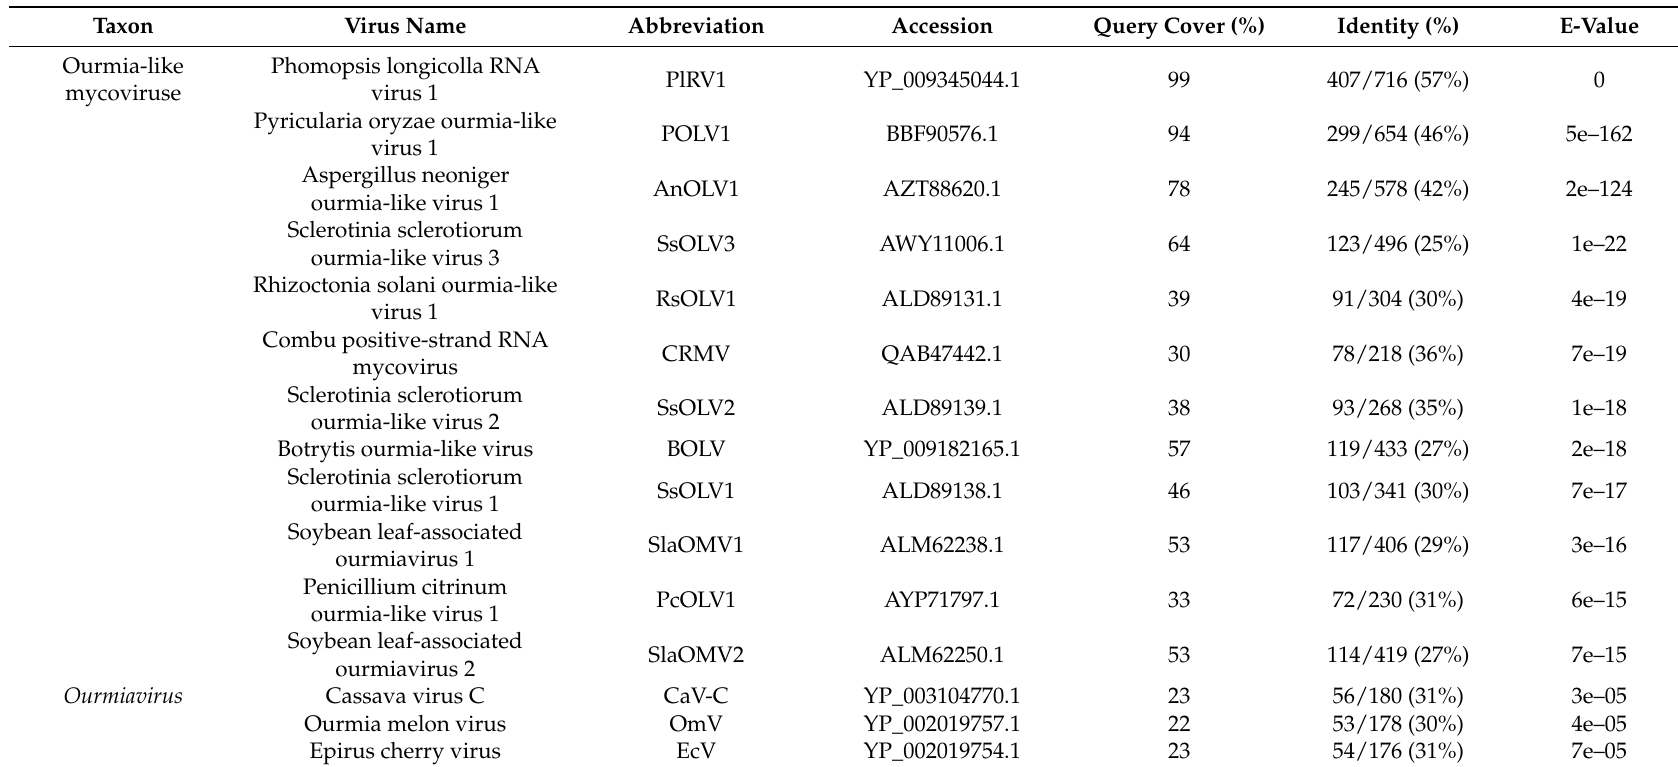
Table 1. Information of BLASTp search results of the RNA-dependent RNA polymerase (RdRp) of Magnaporthe oryzae ourmia-like virus 4 (MOLV4). Taxon